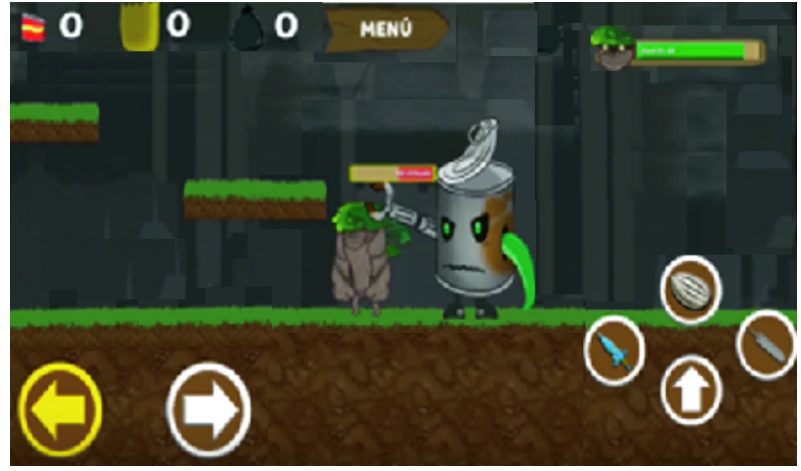
Figure 4. Wood of War encourages players to map trash by using real-world data to spawn trash monsters (Adapted with permission from Ref. [7]).